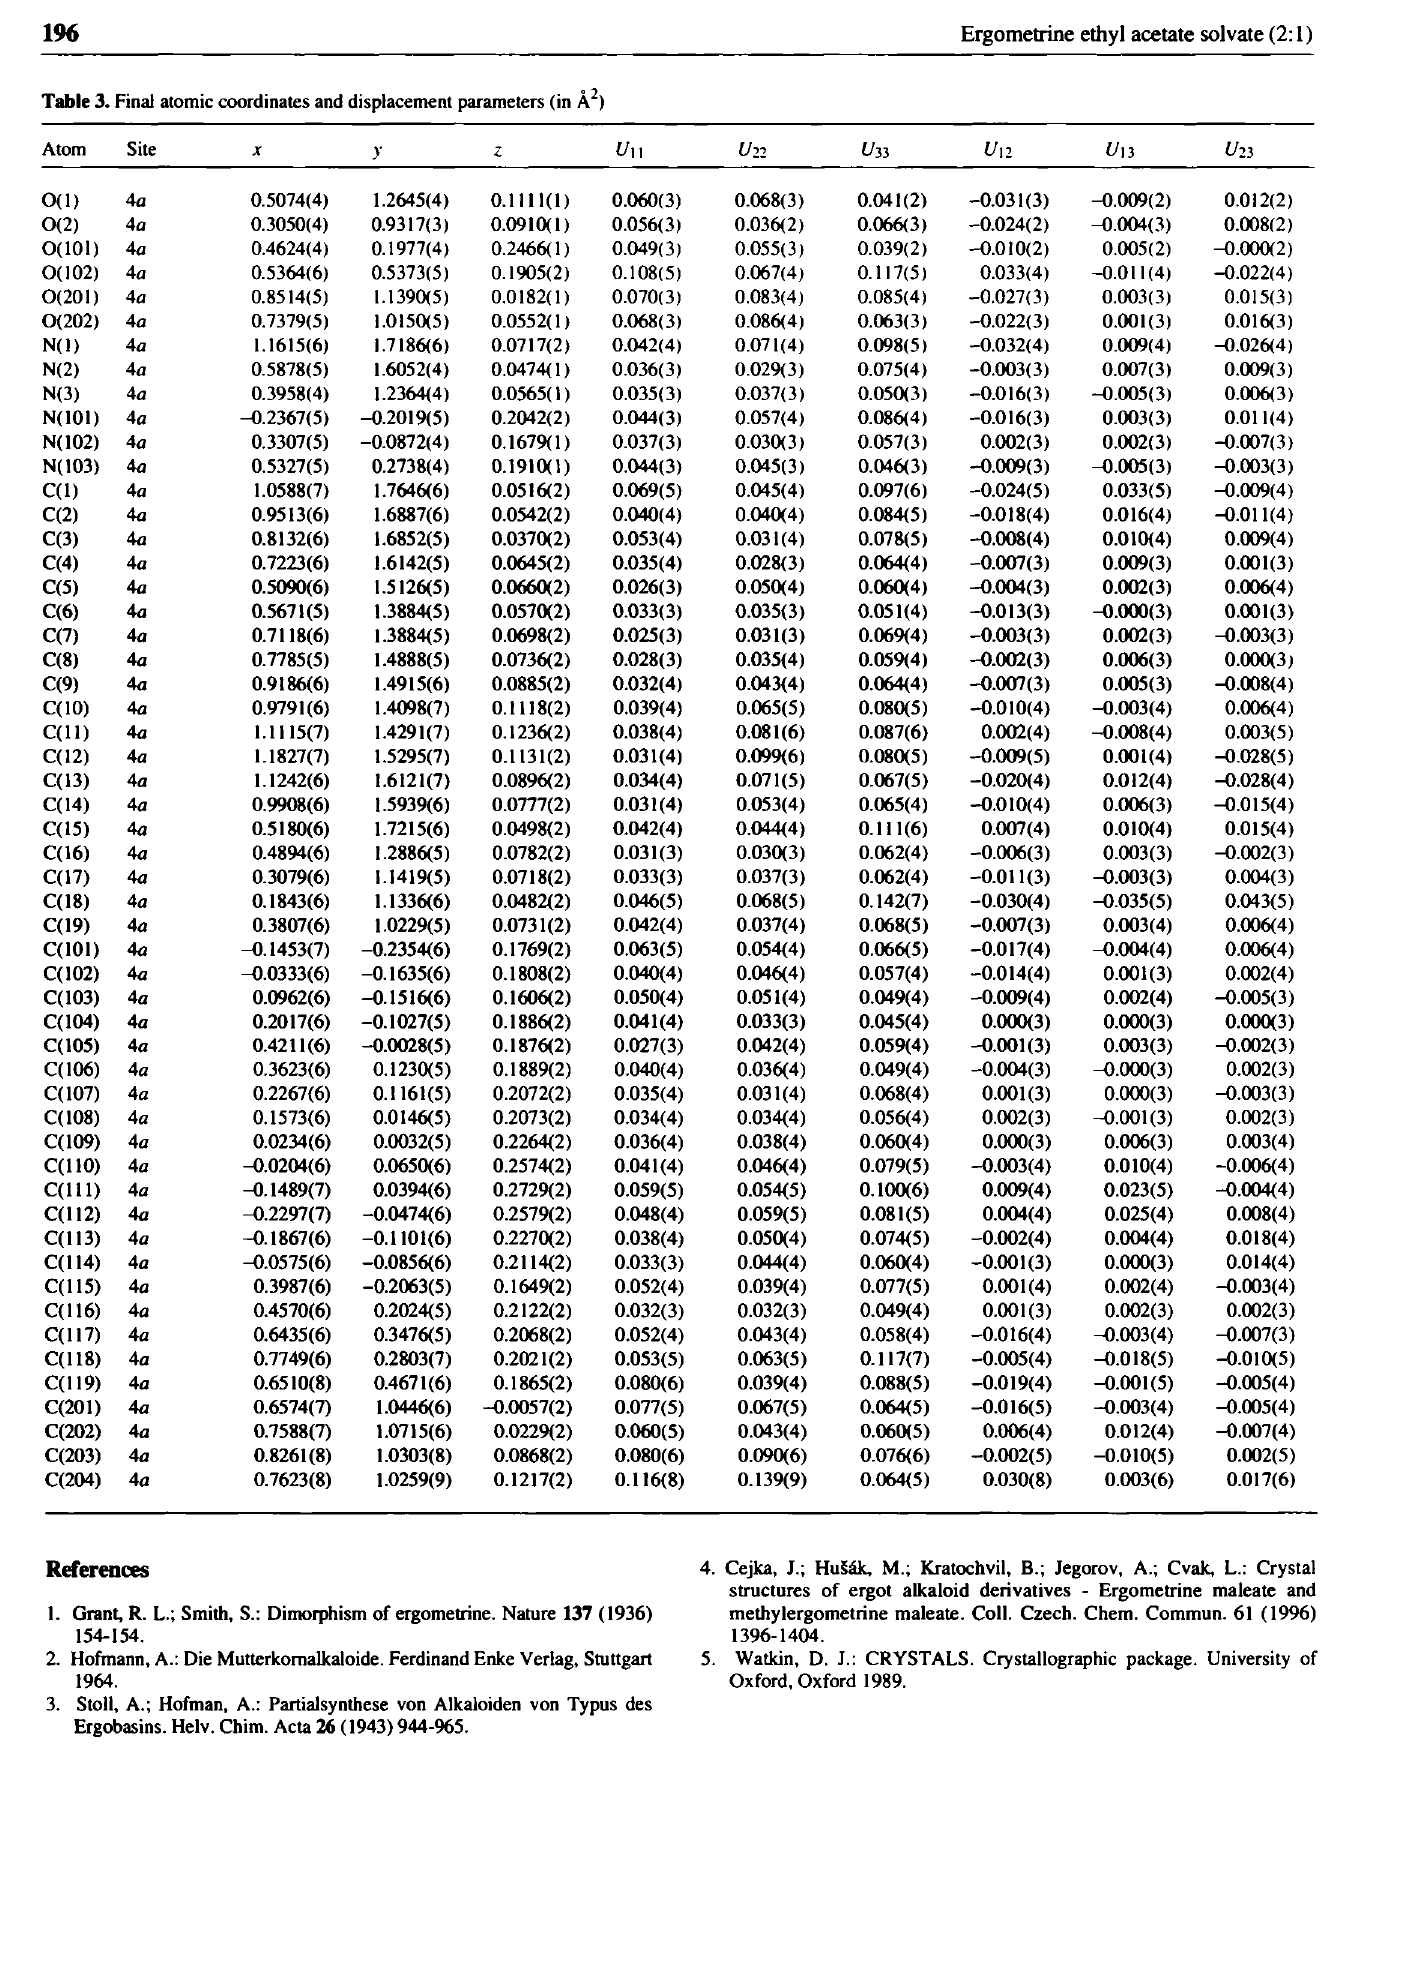
Table 3. Final atomic coordinates and displacement parameters (in Â^) Atom